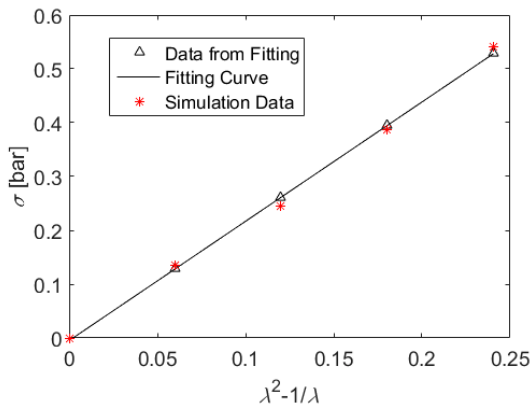
Figure 8. Elongation experiment at small deformations with respect to the undeformed state. Stress-strain simulation data were fitted to Equation (32).